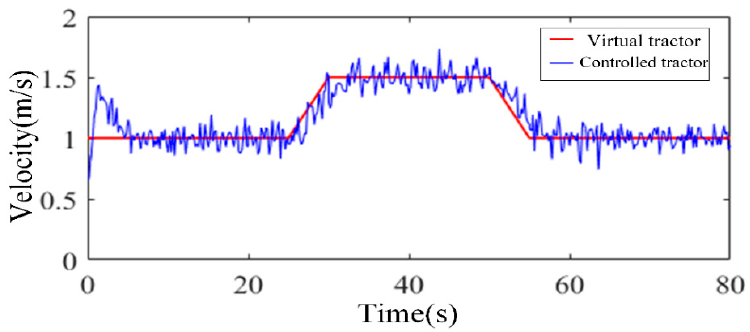
Figure 13. Tractor velocity following